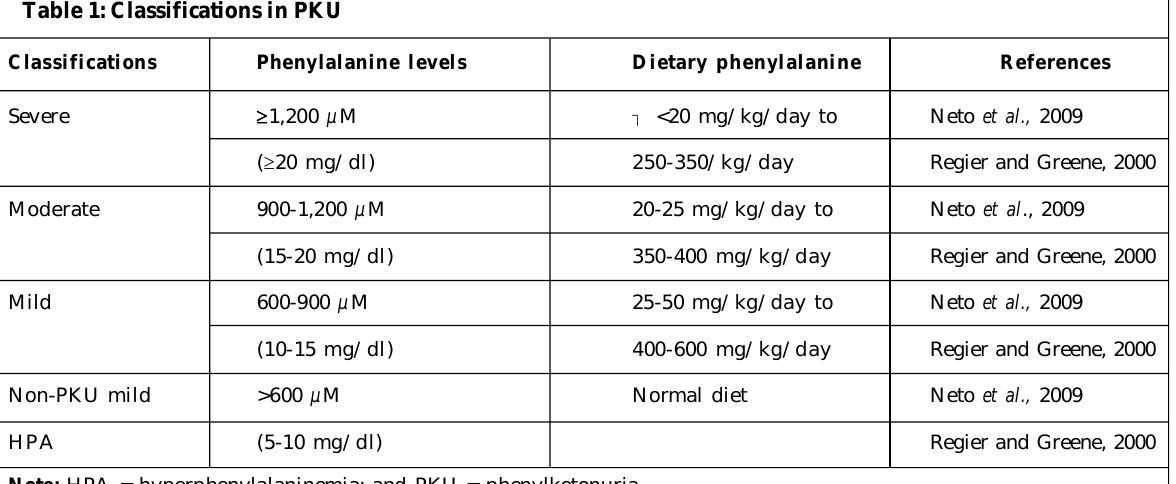
Table 1: Classifications in